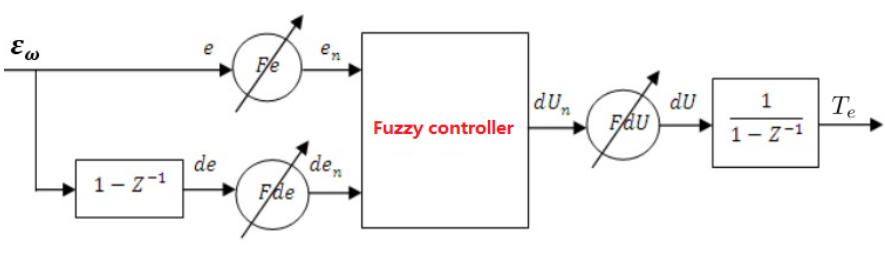
Figure 3. Block diagram: speed regulator with fuzzy logic.